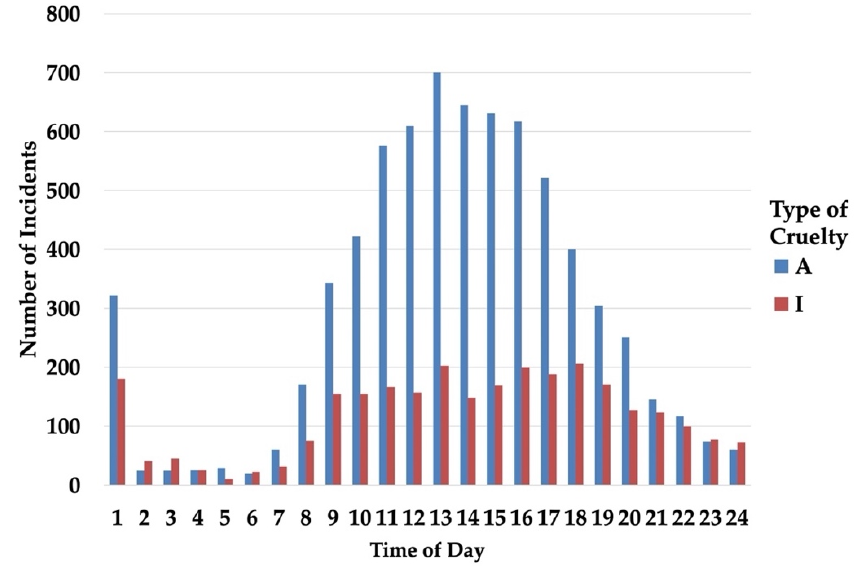
Figure 9. Time of Day of Neglect vs. Intentional Cruelty Incidents.